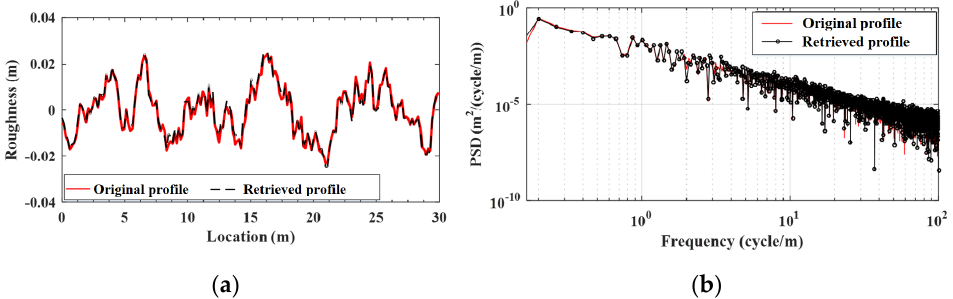
Figure 11. Retrieved and original surface profile (Class C roughness). ( a ) spatial domain; ( b ) frequency domain.